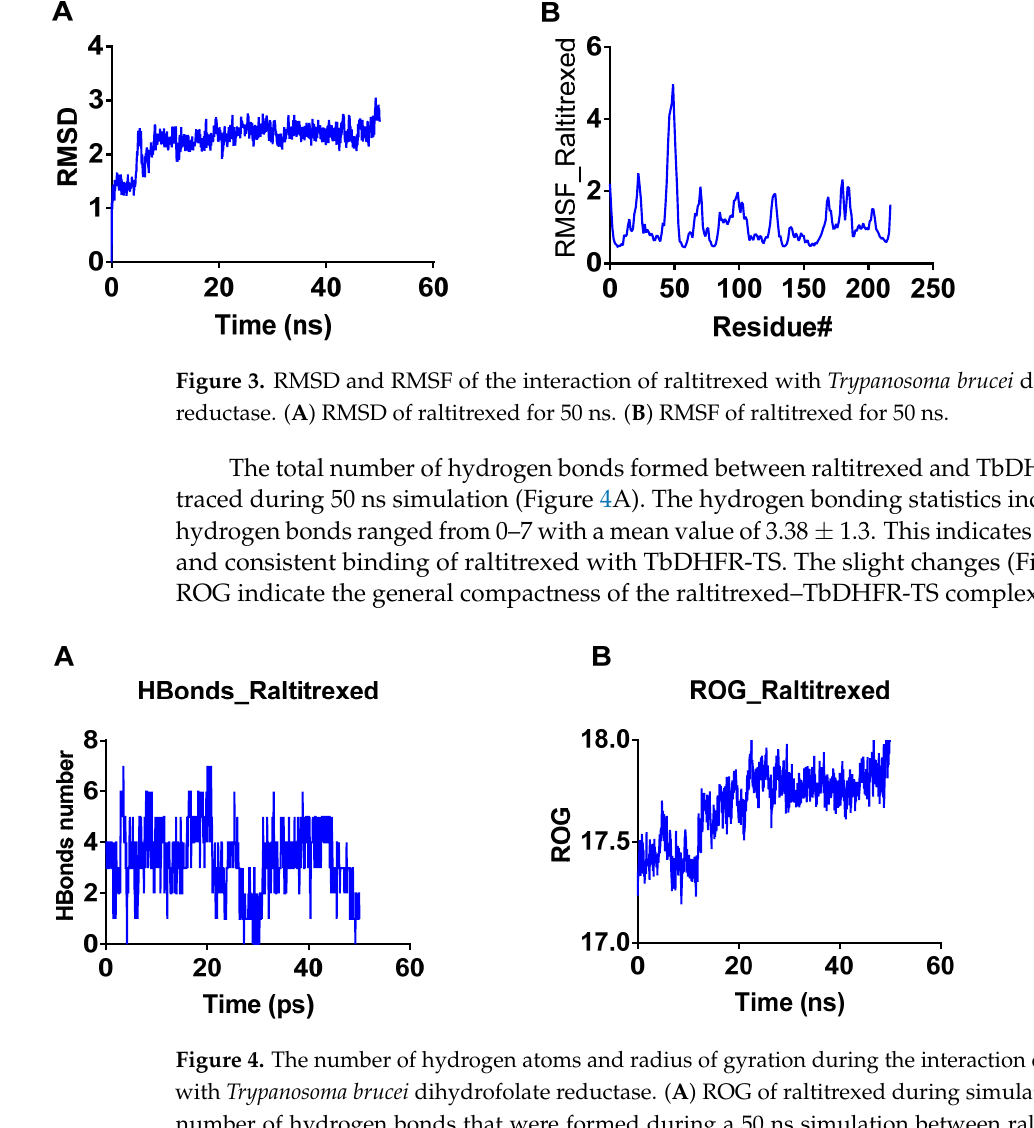
Figure 4. The number of hydrogen atoms and radius of gyration during the interaction of raltitrexed with Trypanosoma brucei dihydrofolate reductase. ( A ) ROG of raltitrexed during simulation. ( B ) The number of hydrogen bonds that were formed during a 50 ns simulation between raltitrexed and T. brucei dihydrofolate reductase.